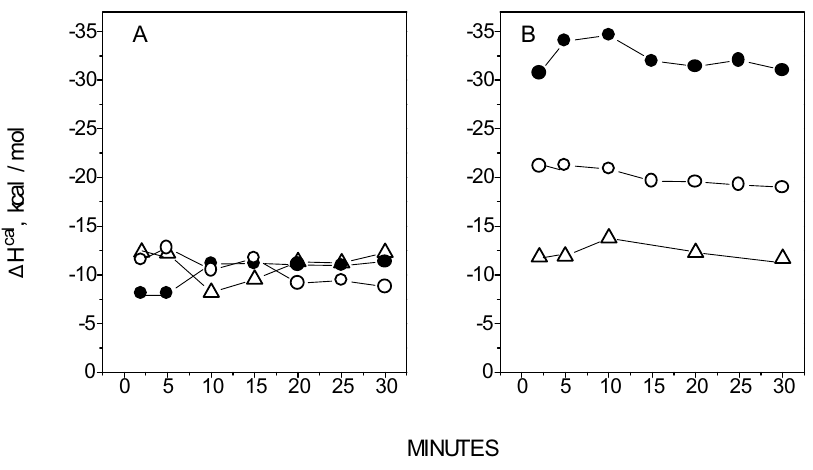
Fig. 4 – Effect of Ca 2 + gradient on the values measured with platelet (A) and skeletal muscle (B) vesicles. The experimental conditions were as described in Table IV. The